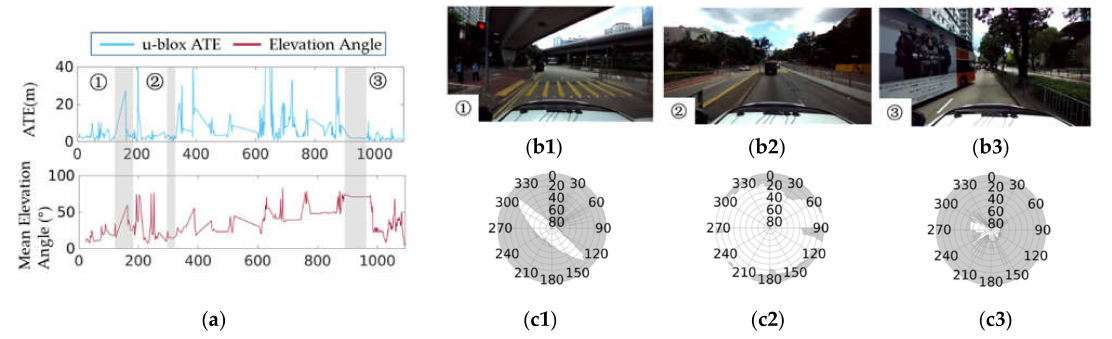
Figure 10. ( a ). The top panel shows the ATE of the u-blox RTK solutions produced by RTKLIB [7] collected in urban-3. The bottom panel shows the mean elevation angle mask of the local point cloud map around the correspondent u-blox epoch. The mean elevation angle mask is defined as that of a fixed-size local map with 50 m (Euclidean distance) both forward and backward the rover. Thus u-blox epochs within 50 m from the start and the end have no corresponding mean elevation angle masks. 1 (cid:13) , 2 (cid:13) , and 3 (cid:13) denote representative cases. ( b1 – b3 ) are streetscapes of the three places denoted in ( a ) respectively. ( c1 – c3 ) are the sky masks of the three places denoted in ( a )